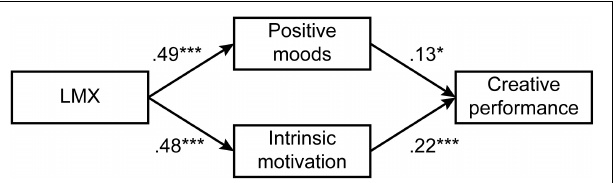
FIGURE 1 | Structural equation model with moderation results. * p < 0.05, *** p <